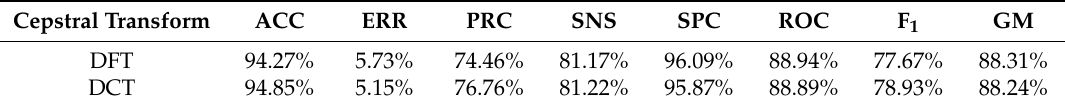
Table 8. Classification performance metrics vs. cepstral transform.